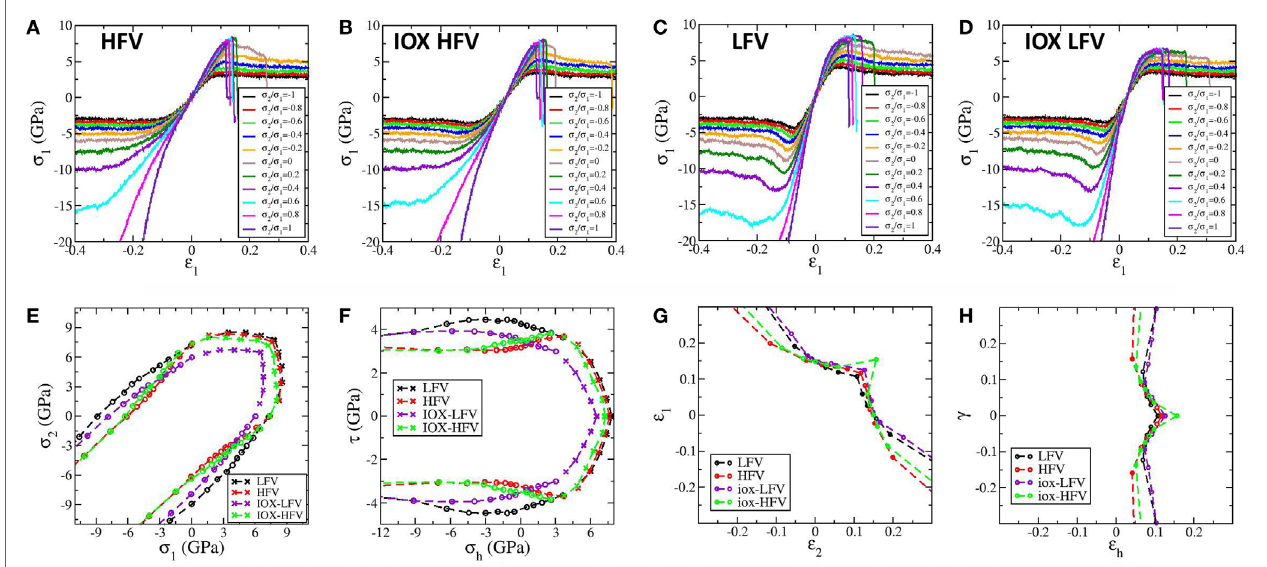
FigUre 6 | stress–strain curves under labeled stress ratios of σ 2 / σ 1 for high free volume (hFV) sample, high free volume after ion exchange (iOX hFV), low free volume (lFV) sample, and low free volume sample after ion exchange (iOX lFV) in (a–D), respectively . (e) The fracture and yield locus the in-plane principal stress domain. Fracture is denoted by crosses and yielding is denoted by circles. (F) The fracture and yield locus in the domain of in-plane hydrostatic stress and maximum shear stress. (g) The in-plane principal strains at fracture. (h) The hydrostatic strain and shear strain at fracture. Note the existence of minimal values in hydrostatic strains at a shear strain of around 0.1 for all the four